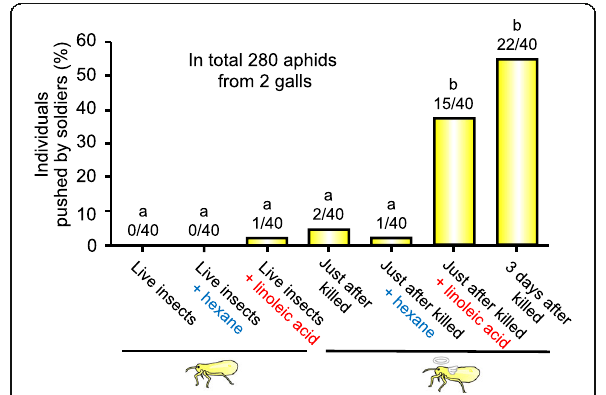
Fig. 7 Cleaning behavior of soldiers of T. styraci against live and dead aphids treated with linoleic acid. For each experimental treatment, 10 non-soldier test insects were introduced into the artificial diet arena containing 100 young soldiers, and continuously observed for 30 min to monitor whether they are pushed by soldiers or not. Live non-soldier aphids and freshly killed non-soldier aphids were subjected to no treatment as negative control, hexane treatment as solvent control, and linoleic acid treatment, which were replicated 4 times respectively. Dead non-soldier aphids 3 days after killing were also examined as positive control. In total, 280 non- soldier test insects derived from two galls were subjected to the experiments. The numbers of non-soldier insects pushed by soldier(s) were compared between the experimental treatments. Different alphabetical letters ( a – b ) indicate statistically significant differences (GLMM with sequential Bonferroni; P < 0.05)